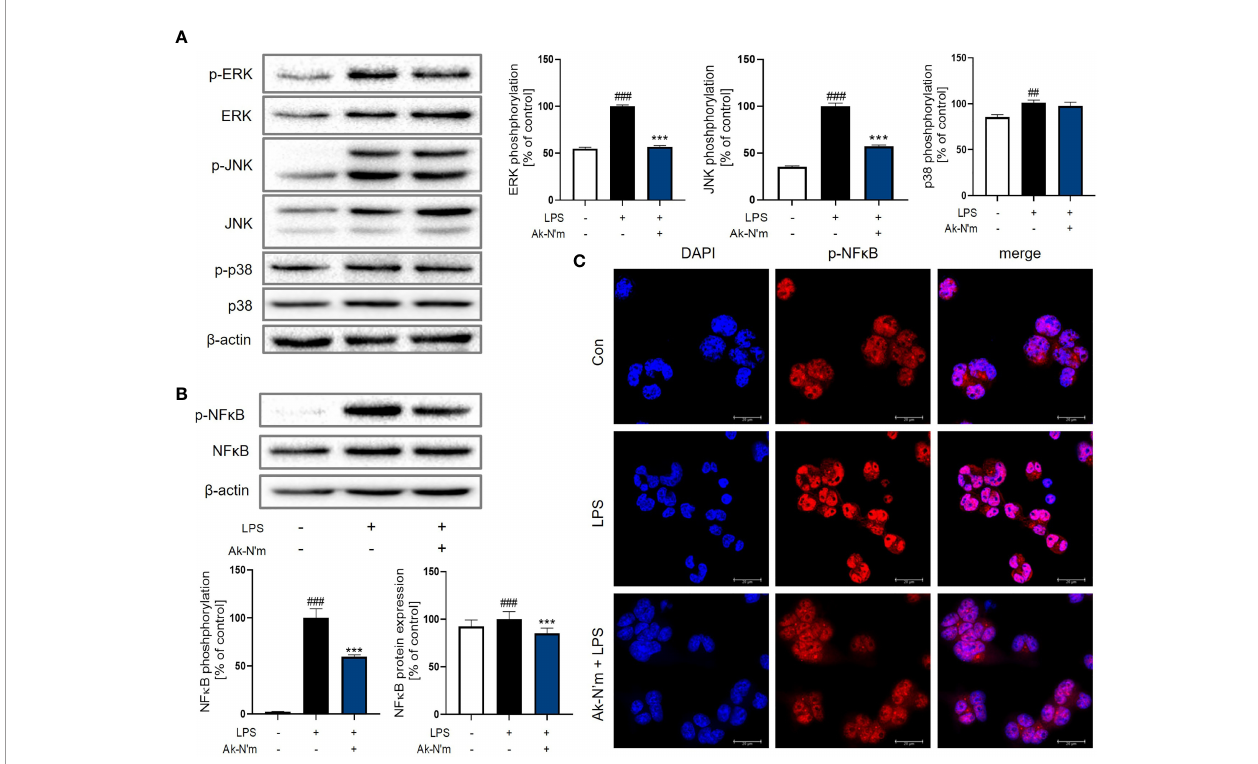
FIGURE 8 | Inhibition of MAPK pathway by Ak-N ’ m in macrophages. Ak-N ’ m affected MyD88-dependent pathway by inhibiting MAPK signaling. (A) Western blot analysis showed inactivation of ERK and JNK by 2 m M Ak-N ’ m treatment. (B) The expression and activation of the transcription factor NF- k B was suppressed by the peptide. (C) The nuclear translocation of NF- k B was inhibited by AK-N ’ m on LPS-stimulated macrophages. Data are presented as mean ± SEM. ## p < 0.01 and ### p < 0.001 represent signi fi cant difference between the negative and positive control. ***p < 0.001 represents signi fi cant difference between LPS-stimulation and co-treatment of LPS and Ak-N ’